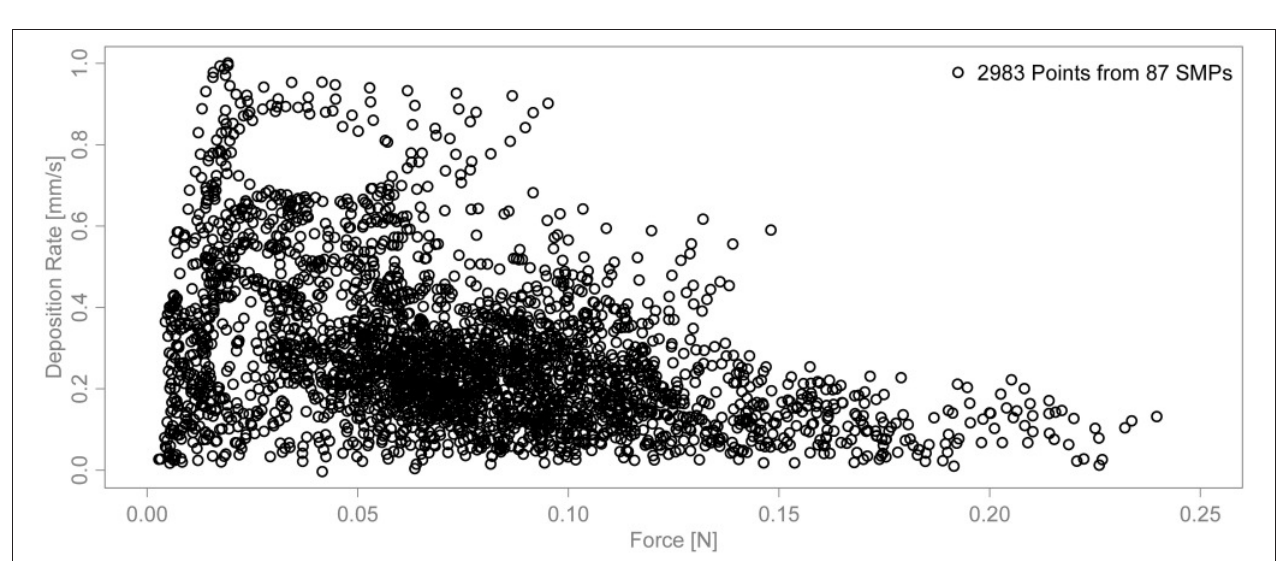
FIGURE 10 | Scatterplot of the deposition rate against the SMP force. The plot shows the 2,983 points with Sx < 0.2 from the same 87 SMPs as in Figure 9 .